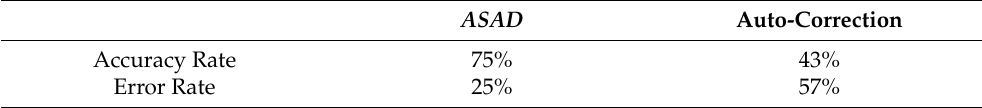
Table 8. Results of seasonal length evaluation.